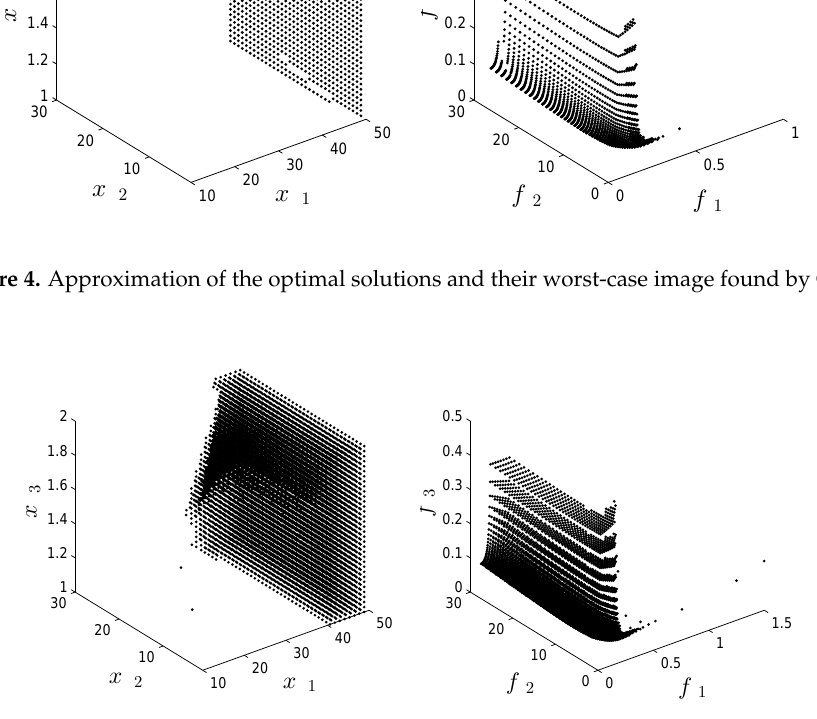
Figure 5. Approximation of the nearly optimal solutions and their worst-case image found by GCM.